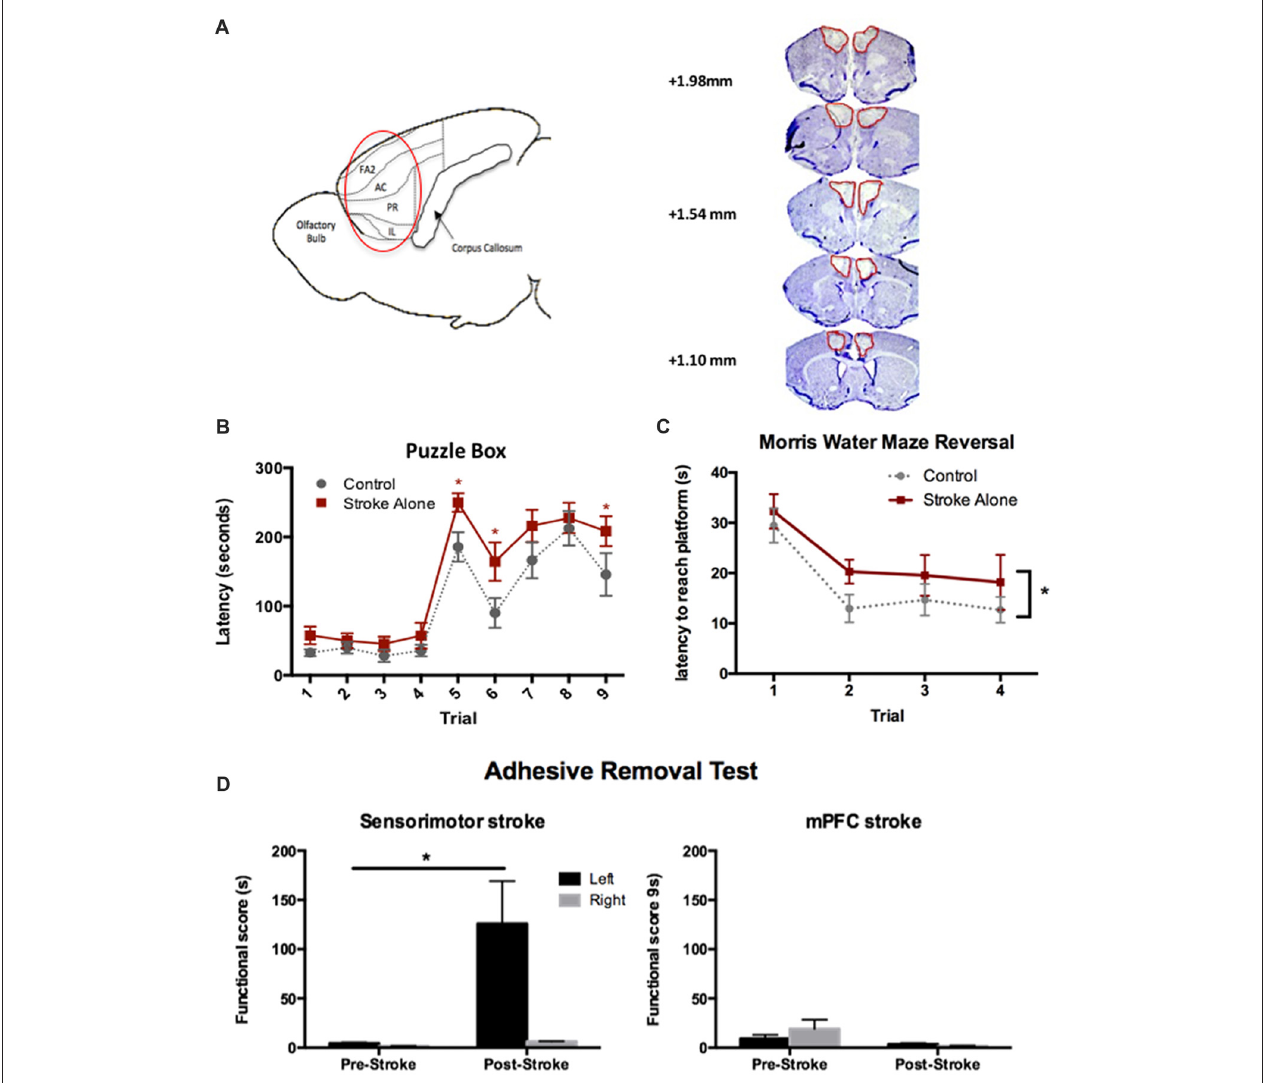
FIGURE 1 | Endothelin-1 (ET-1)-induced cognitive model of stroke in mice. (A) Sagittal representation of the lesioned areas of the brain (circled). FA2, frontal area 2; AC, anterior cingulate cortex; PR, prelimbic; IL, infralimbic; cresyl violet stained coronal sections depicting typical medial prefrontal cortex (mPFC) lesion on day 4 post-stroke. (B) Significant cognitive impairments following stroke were detected using the Puzzle Box (PB) task at day 4–6 compared to control ( n = 18 stroke; 16 control). (C) Following stroke, a significant cognitive deficit was detected up to 45 days, using the Morris Water Maze (MWM) reversal test ( n = 12 stroke; 10 control). (D) Post-stroke functional scores in the adhesive removal test. Unilateral sensory-motor ( n = 3), but not bilateral mPFC ( n = 7) stroke, resulted in contralesional (left) forepaw deficits compared to baseline performance. ∗ p <